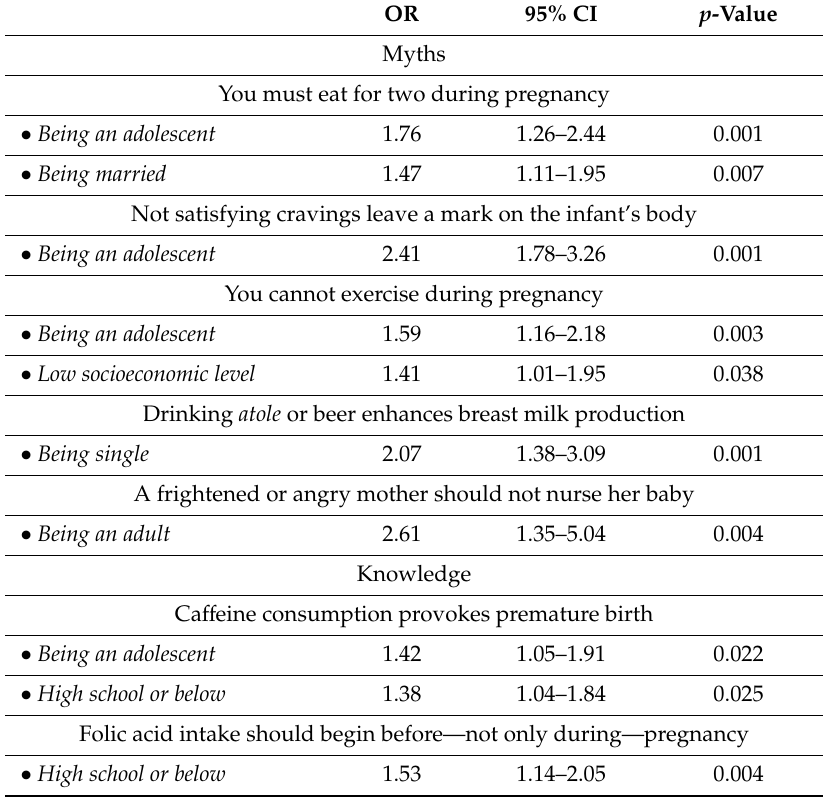
Table 6. Variables associated with acting on myths and not practicing